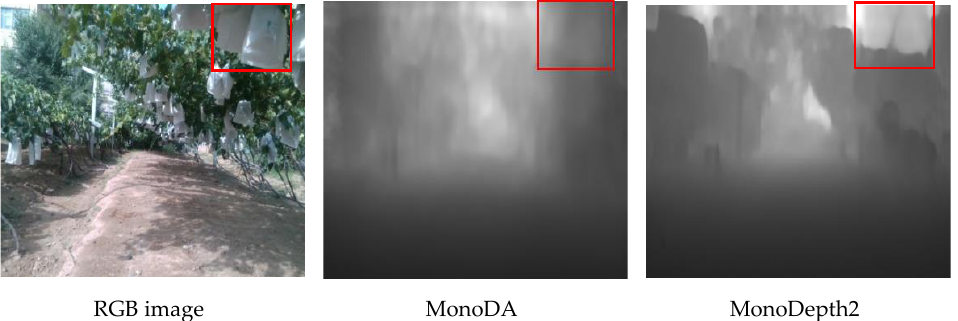
Figure 6. The example depth maps inferred by models with Kitti image.